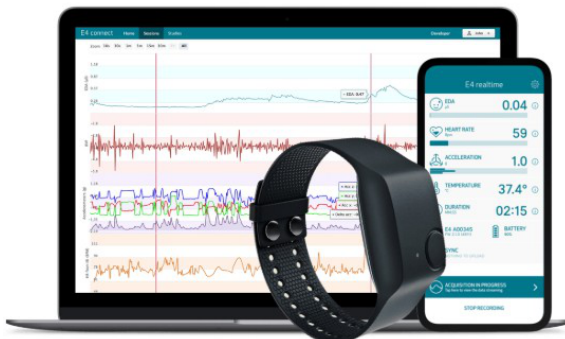
Figure 1. Empatica E4 Ecosystem implementing both computer (therapy management by the clinicians) and smartphone (data processing and display during patient use), retrieved from Reference [16].